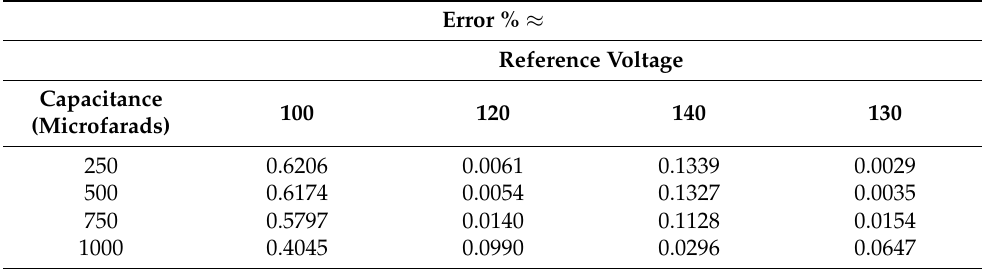
Figure 7. Output voltage of a boost converter under changes in reference voltage and capacitance. Table 2. Percentage of error in the output voltage due to changes in